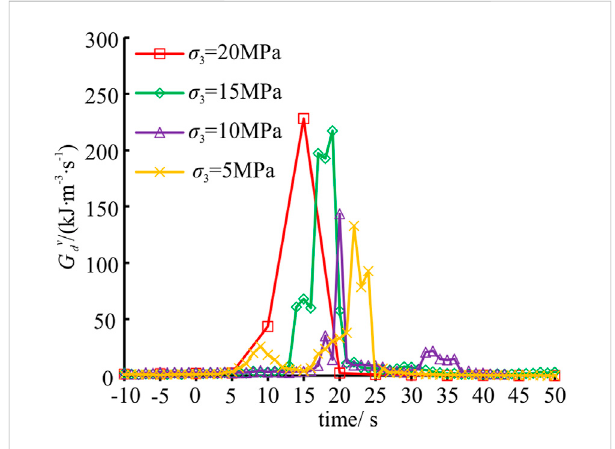
FIGURE 11 Energy dissipation rate near peak